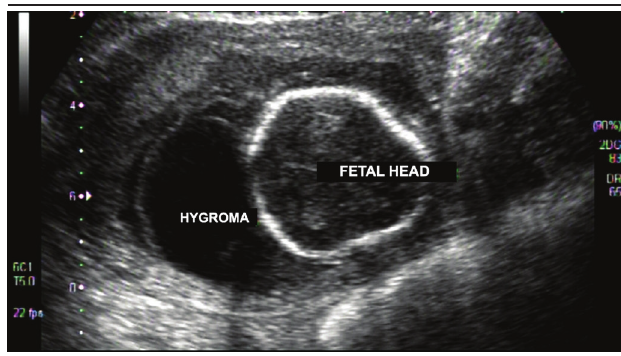
figurE 1 − Fetal ultrasound performed at 16 weeks of gestation showing the cystic hygroma